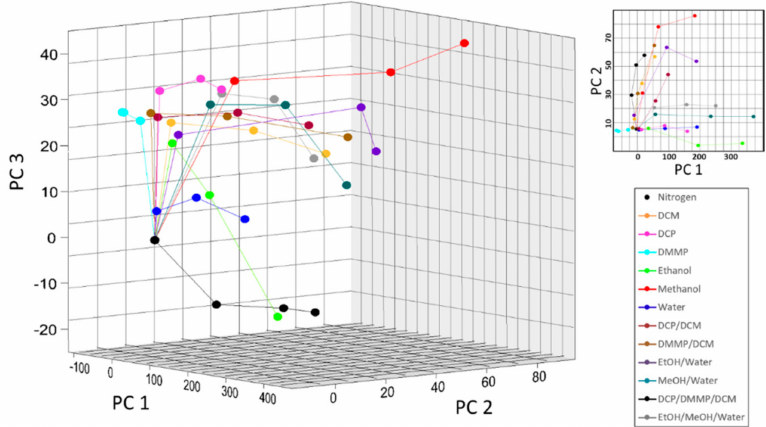
Figure 5. PCA score plots for individual and mixed vapors showing good selectivity, where the first three principle components (PCs) captured 93.0% of the total spectral variance (PC 1 = 87.5%, PC 2 = 4.2%, and PC 3 =